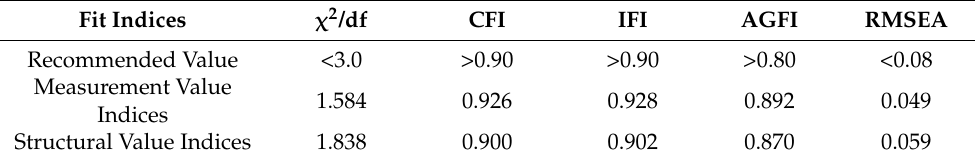
Table 2. Model fit indices.